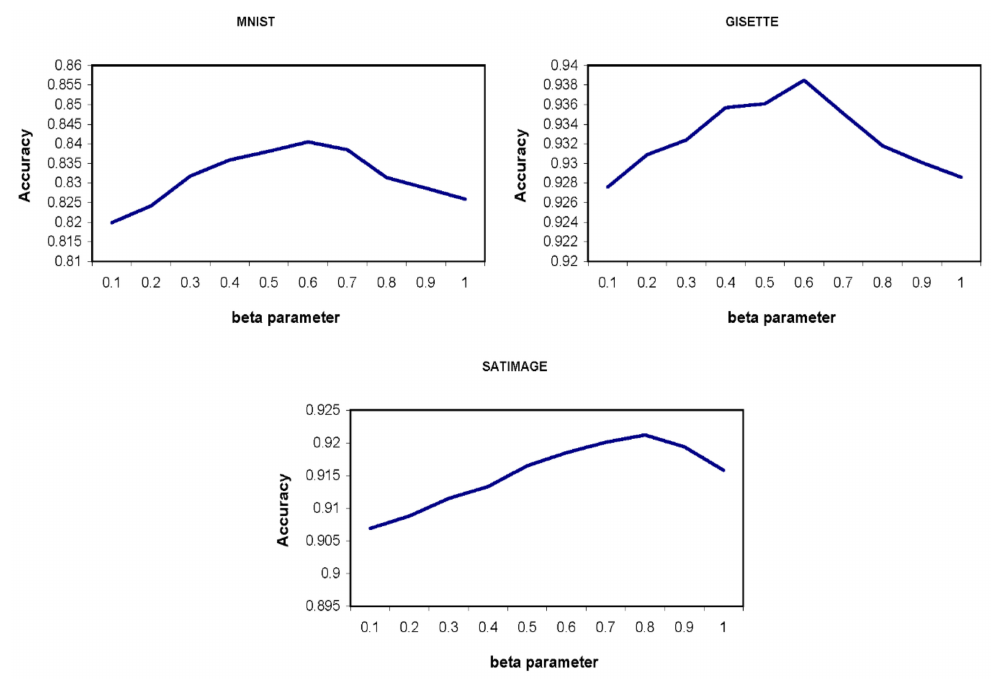
Figure 4. Classification accuracy of the proposed approach for di ff erent values of the β parameter. As it can be seen, the proposed approach has a better performance for the value of 0.7 on average.